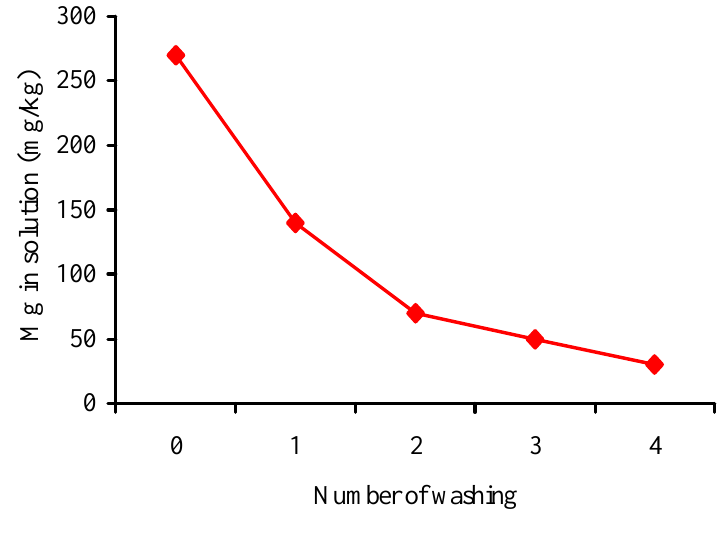
FIGURE 3 . Effect of washing on Mg removal from HA.